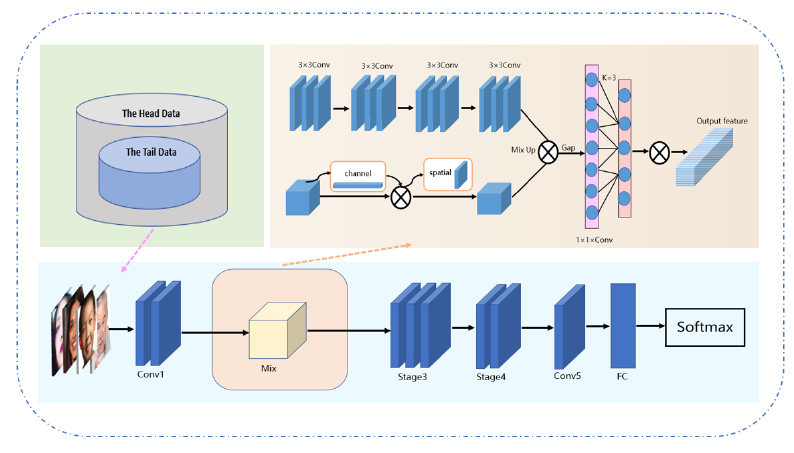
Figure 3. In the overall architecture framework diagram, the upper left corner is our proposed oversampling method, and the upper right corner for data enhancement is our proposed attention mechanism-based fusion of global and local features; that is, the mix layer. This part consists of three modules: channel space modulator, local feature layer, and attention mechanism module. At the bottom is our backbone